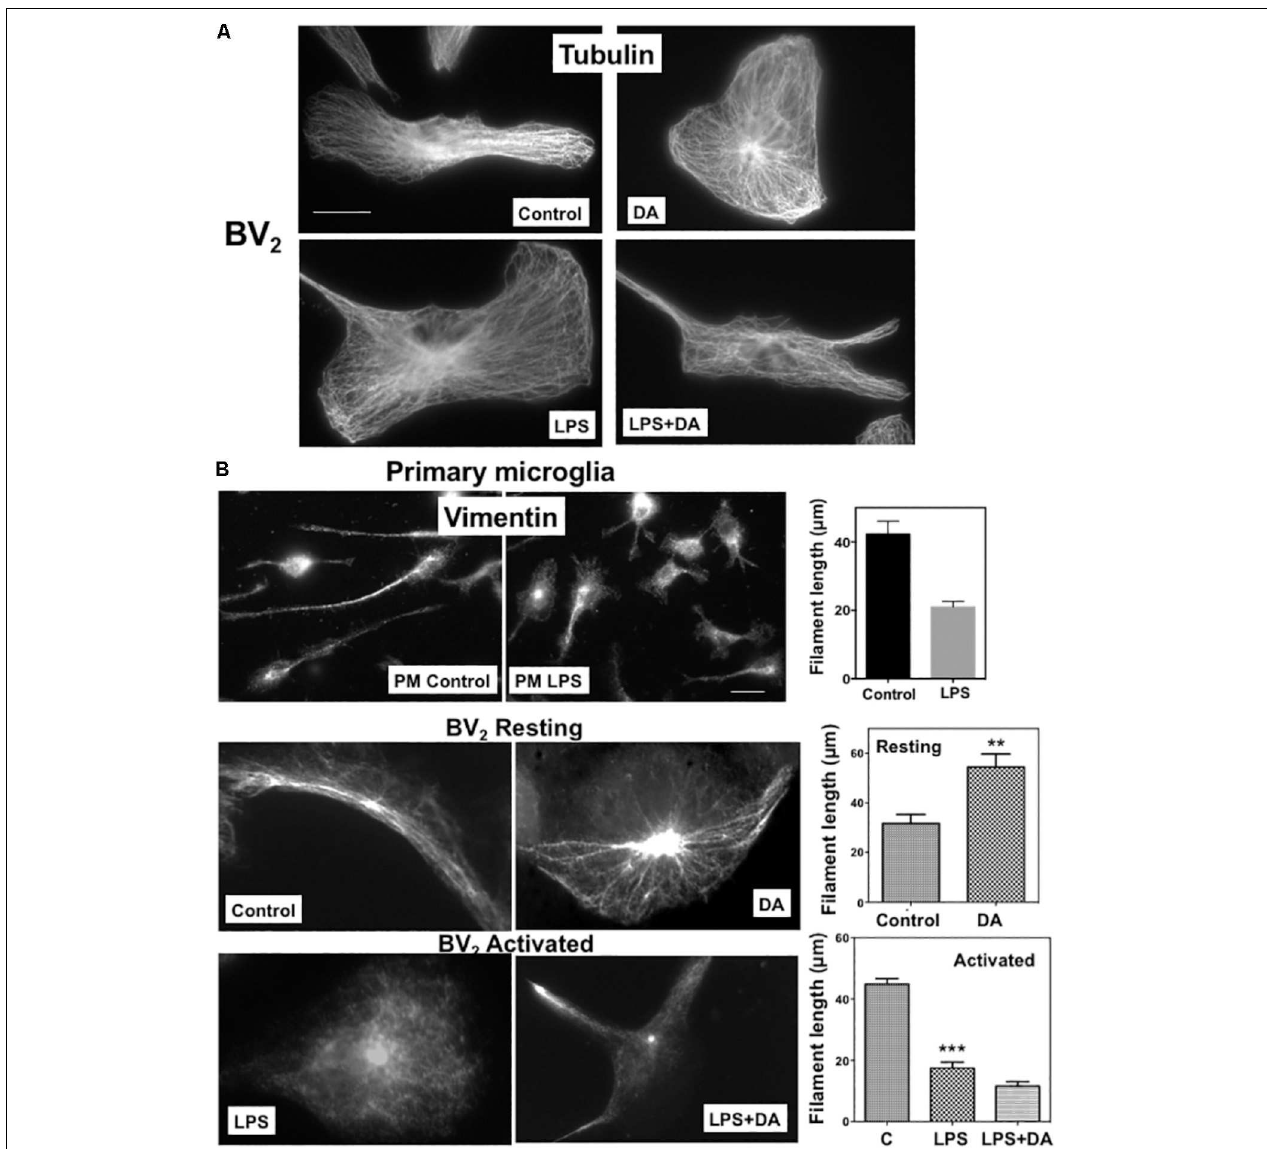
FIGURE 2 | Changes in microglia cytoskeleton upon DA stimulation. (A) Microtubule organization shown by immunofluorescence staining with a β -tubulin antibody. Resting and activated BV 2 microglia with or without DA (2 µ M) treatment showed little changes in microtubule organization. Scale bar = 10 µ m. (B) Changes of vimentin filaments in cells treated with DA for 30 min. The number and length of vimentin filaments in primary (PM) and BV 2 microglia were visualized by immunofluorescence staining. Values are means ± standard error of 10–15 cells. DA (2 µ M) induces the increase of number and length of vimentin filaments in resting BV 2 cells. Loss of vimentin filaments and cell spreading upon the activation of microglia by LPS (100 ng/ml) were observed in both primary and BV 2 microglia. DA could not rescue the loss of vimentin filaments in activated microglia. (ANOVA: ∗∗∗ P < 0.005, ∗∗ P < 0.01compare to control). Scale bar = 10 µ m.